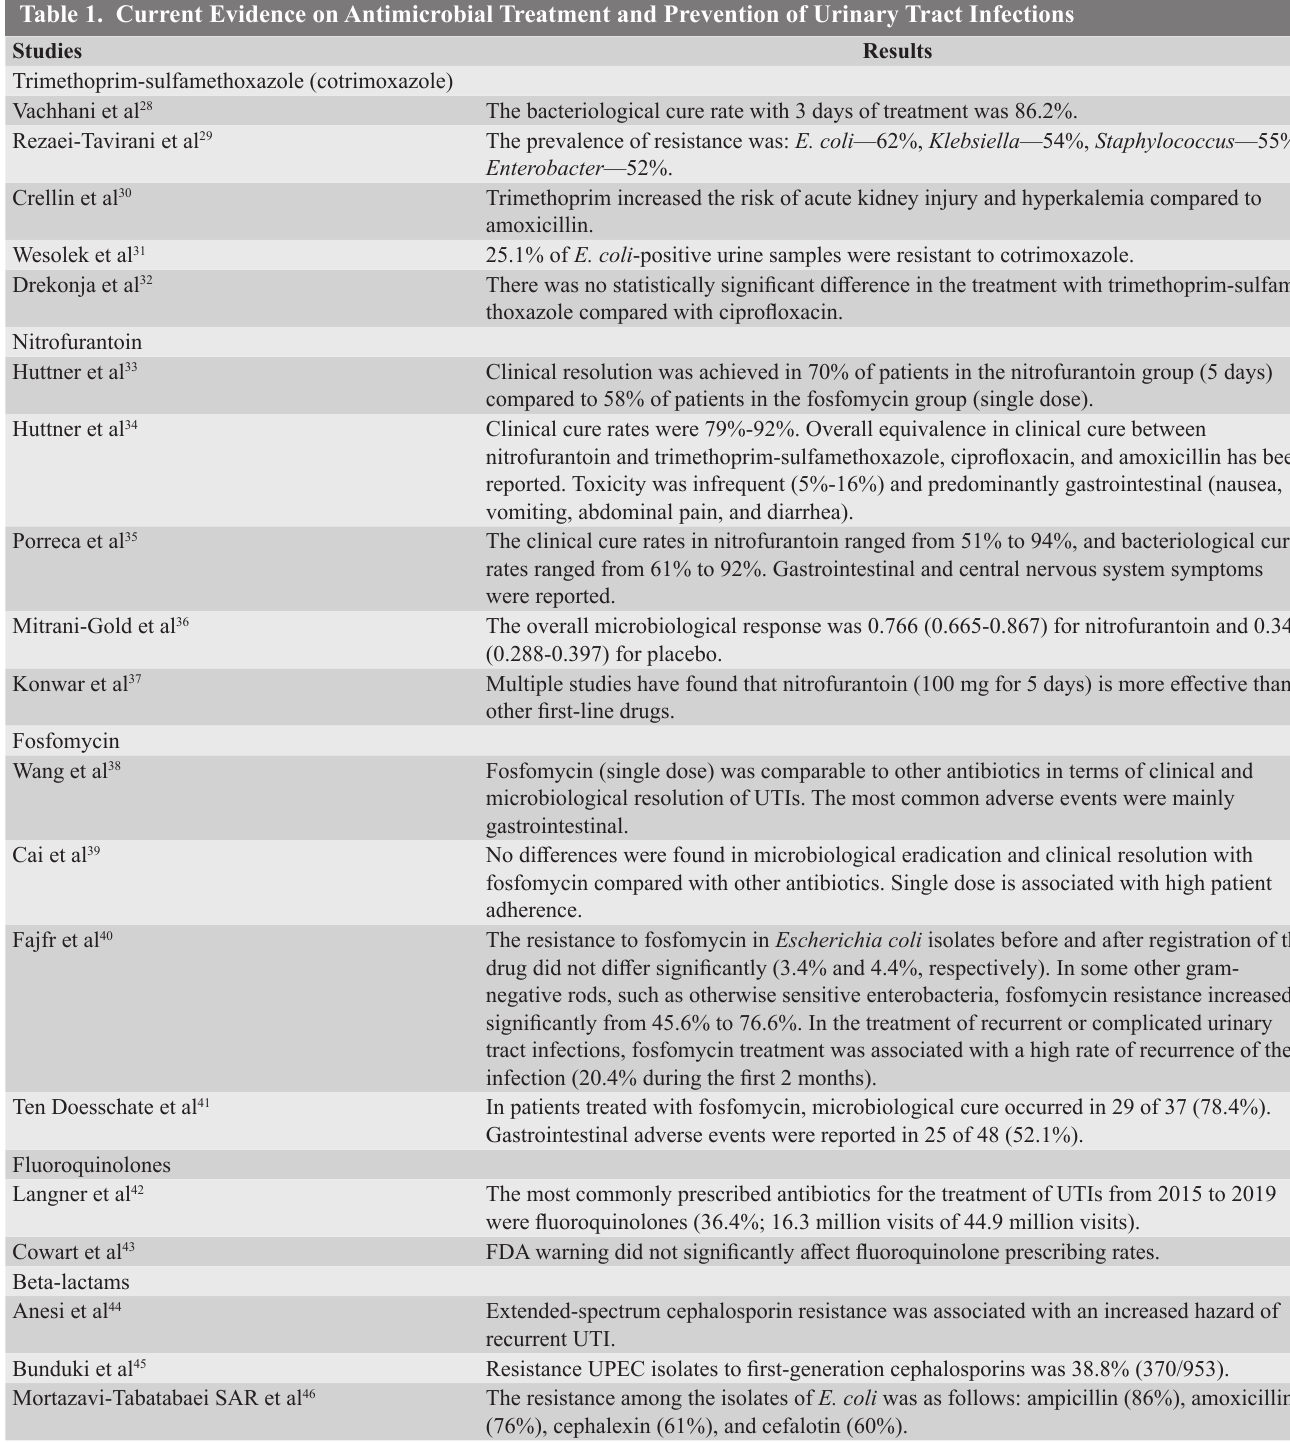
Table 1. Current Evidence on Antimicrobial Treatment and Prevention of Urinary Tract Infections